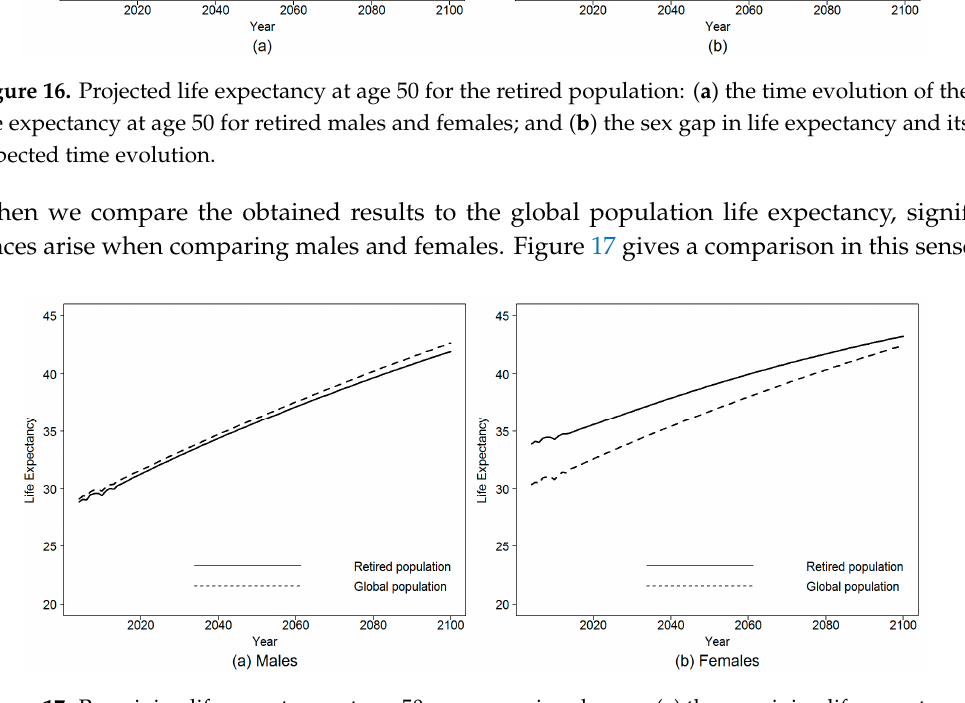
Figure 17 . Remaining life expectancy at age 50—a comparison by sex: ( a ) the remaining life expectancy at age 50 between retirees and global population for males; and ( b ) the same indicator for females.